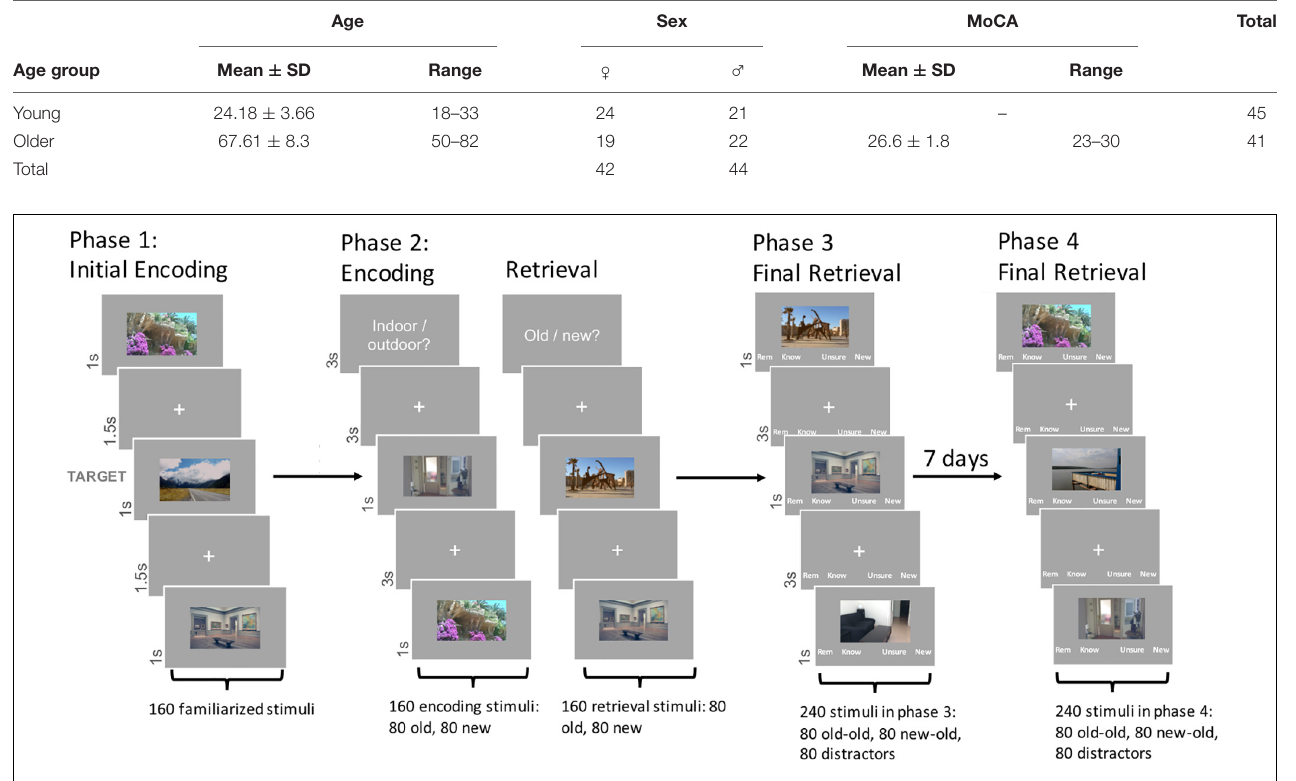
FIGURE 1 | Experimental paradigm. Phase 1 familiarizes participants with 160 stimuli through a target detection task. Stimuli first shown in Phase 1 (old stimuli) are then shown in Phase 2, interspersed with 160 new stimuli, in either one of two tasks, (a) the Encoding Task (ENC), in which images are categorized into indoor or outdoor, or (b) the Retrieval Task (RET), in which participants have to determine whether they have seen the stimulus already or not. In Phase 3, half of all previously encountered stimuli are shown with 80 new distractors and participants have to recall the stimuli, giving recollection/familiarity responses in form of “remember” or “know” responses. Phase 4 follows the same rationale as Phase 3, with the other half of the stimuli, and a week